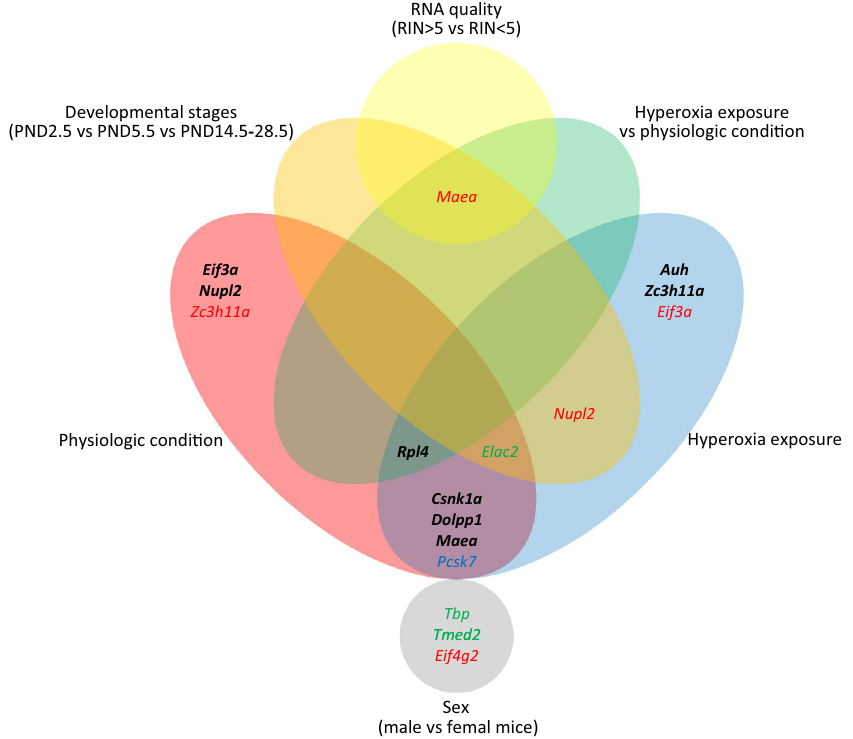
Figure 3. Reference genes with low expression variability (RT-qPCR). Black, bold: Genes with high expression stability identified by both GeNorm and Normfinder. Colored: Genes selected for low expression variability by GeNorm (green) oder Normfinder (red). Pcsk7 (blue) was identified by GeNorm in the hyperoxia condition and by Normfinder in the physiologic condition.